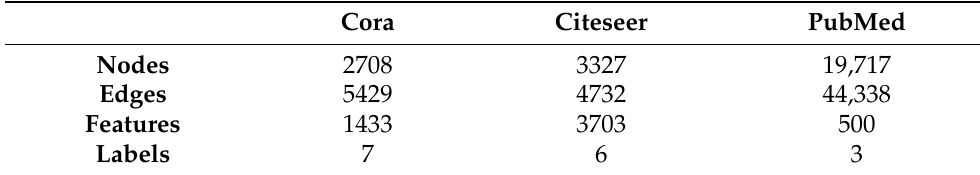
Table 1. Details of the